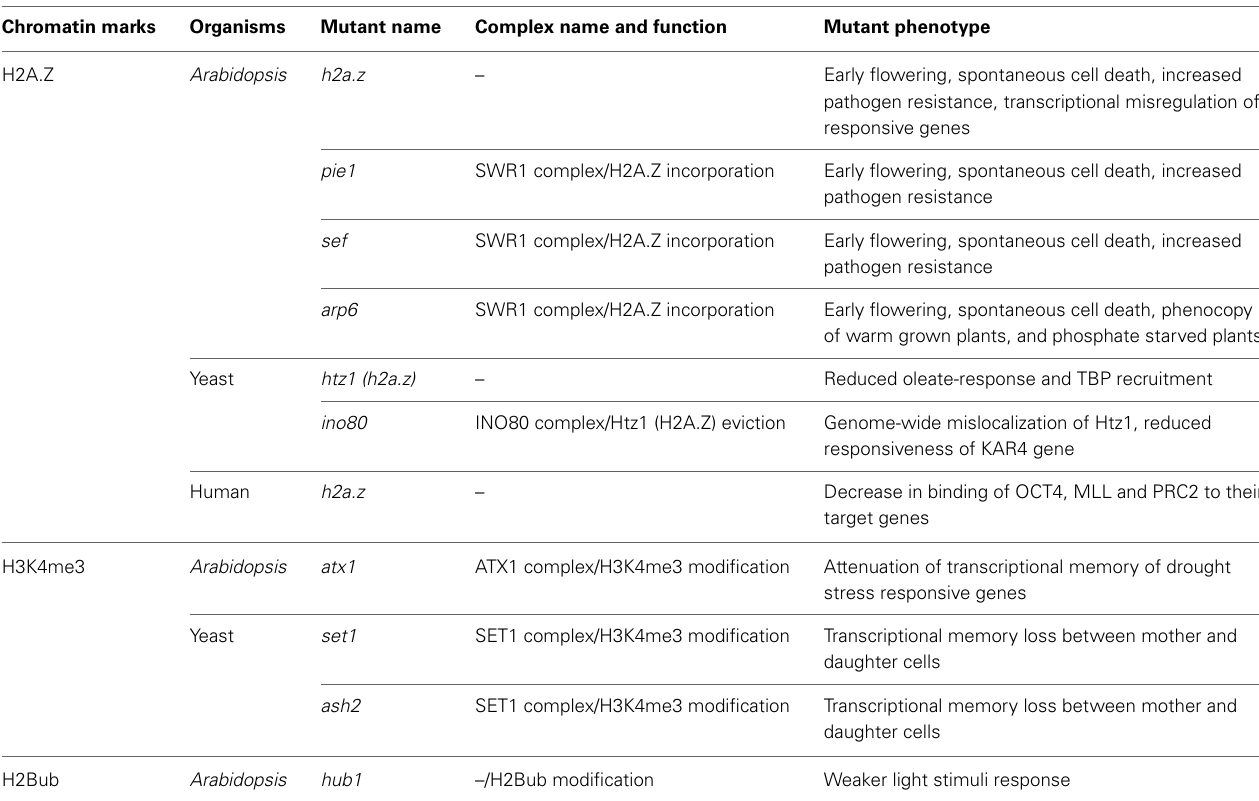
Table 1 | The lists of the chromatin marks and the phenotypes of the mutants written in this review. Chromatin